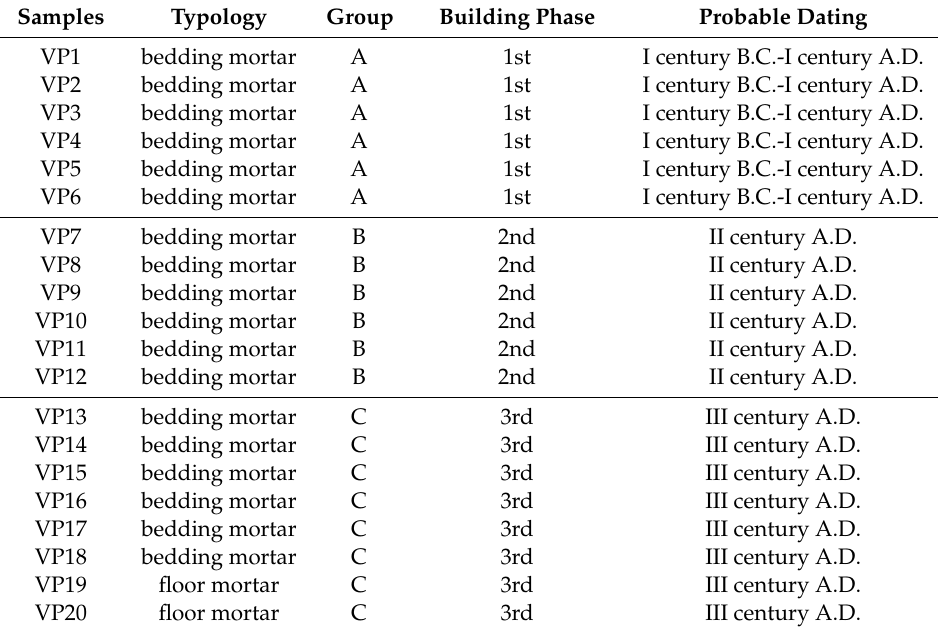
Table 1. List of the mortar samples with relative typology, group, building phase, and probable dating defined by literature